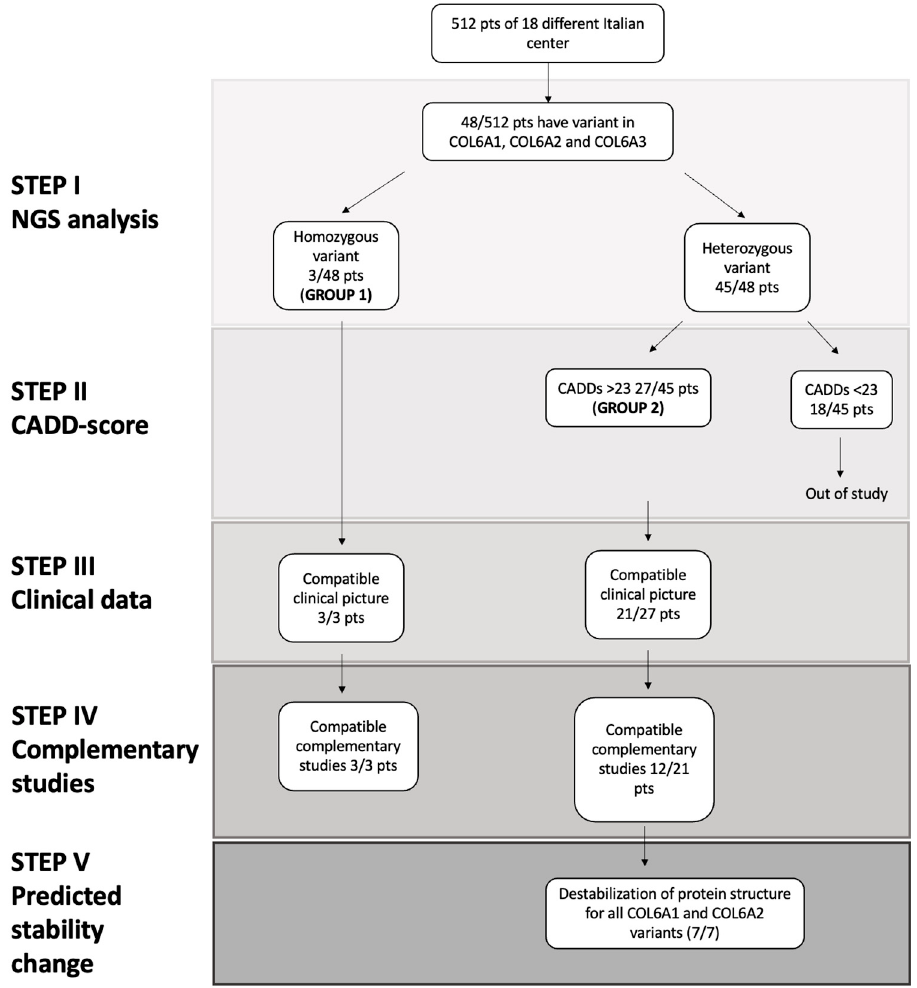
Figure 1. Diagnostic flowchart divided into five progressive steps: Step I Next-generation sequencing (NGS) analysis; Step II CADD score; Step III clinical data; Step IV complementary studies (such as muscle and skin biopsy, study of expression of COLVI on fibroblast or muscle and muscle magnetic resonance); and Step V predicted stability change.